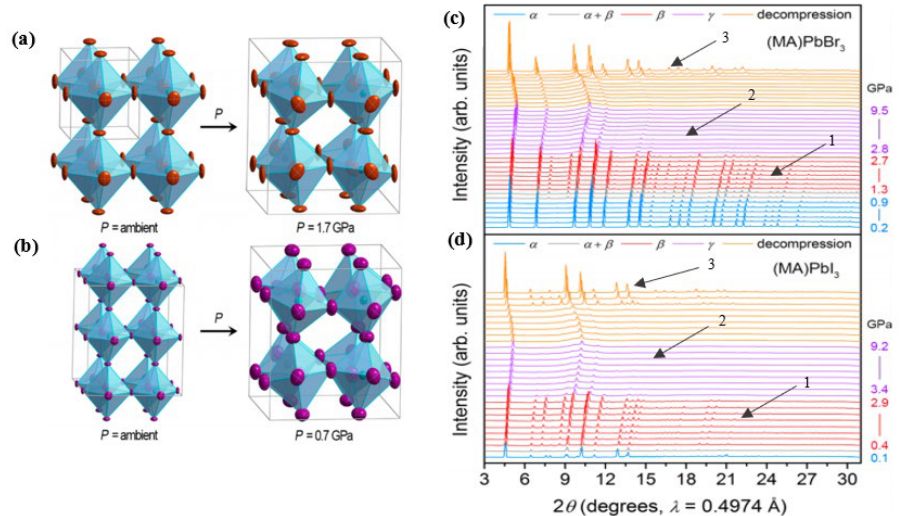
Figure 14. SCXRD schematic representation of crystal structure for ( a ) MAPbBr 3 and ( b ) MAPbI 3 at ambient and high pressures of 1.7 and 0.7 GPa, respectively. Changes in PXRD patterns for ( c ) MAPbIBr 3 and ( d ) MAPbI 3 in response to the applied pressure